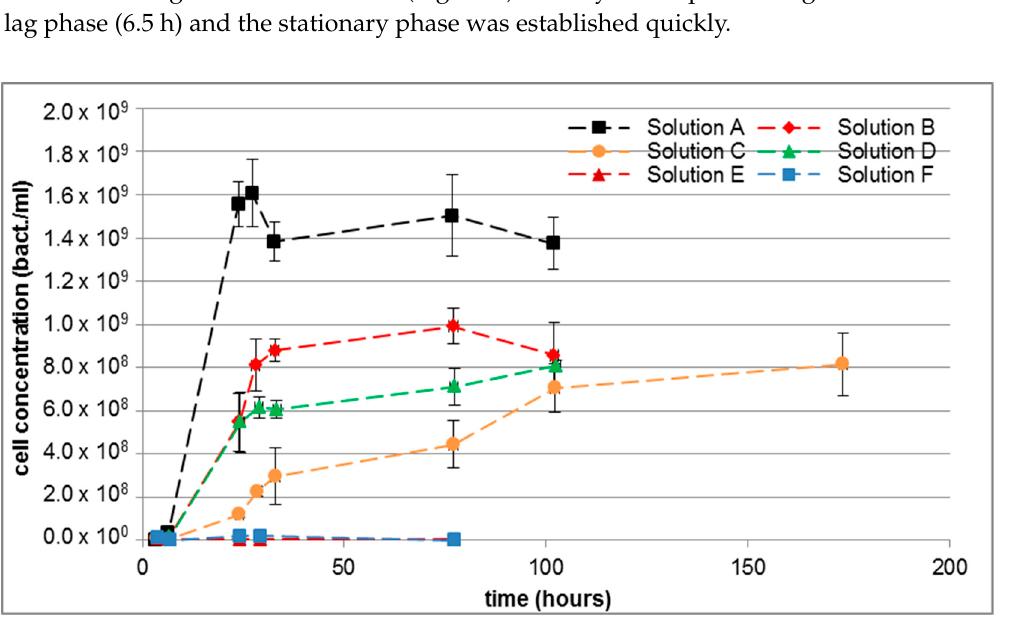
Table 2. Characterization of the grain size fractions.